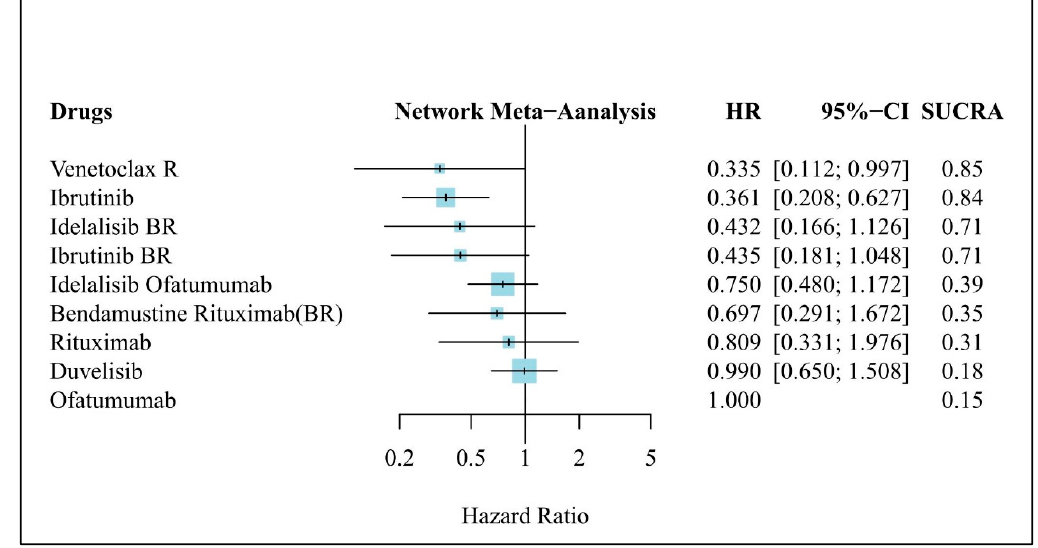
Figure 4. Network meta-analysis results of treatment efficacy in refractory/relapse (R/R) chronic lymphocytic leukemia (CLL): Forest plot of OS in R/R CLL. HR: Hazard ratio, CI: Confidence interval, SUCRA: Surface under the cumulative ranking curve, BR: Bendamustine + Rituximab, R: Rituximab.